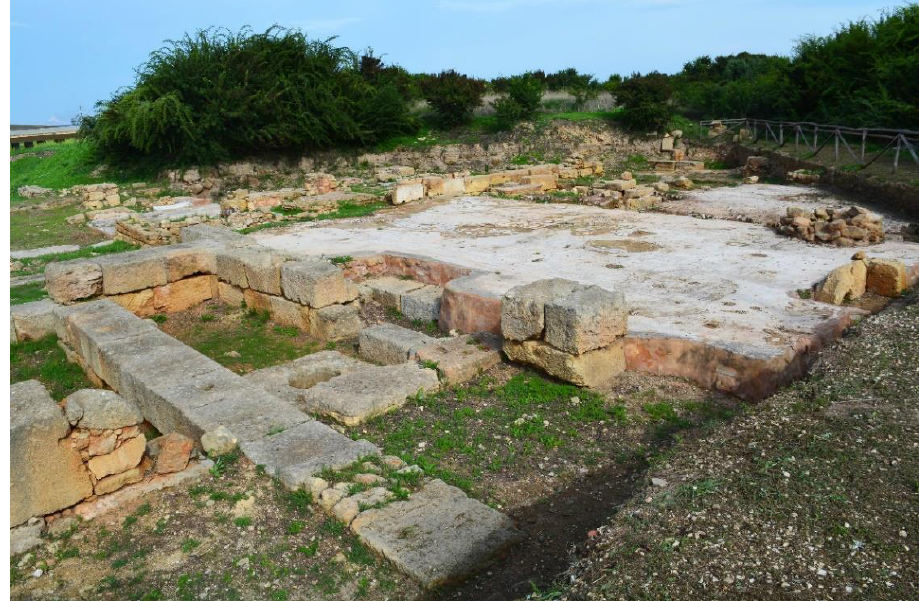
Figure 2. View of the insulae I – III (from Google Earth@) showing the area of the sanctuary of Isis ( a ); plan of the sanctuary of Isis with the three interconnected rooms (room A, room B and room C) ( b ).